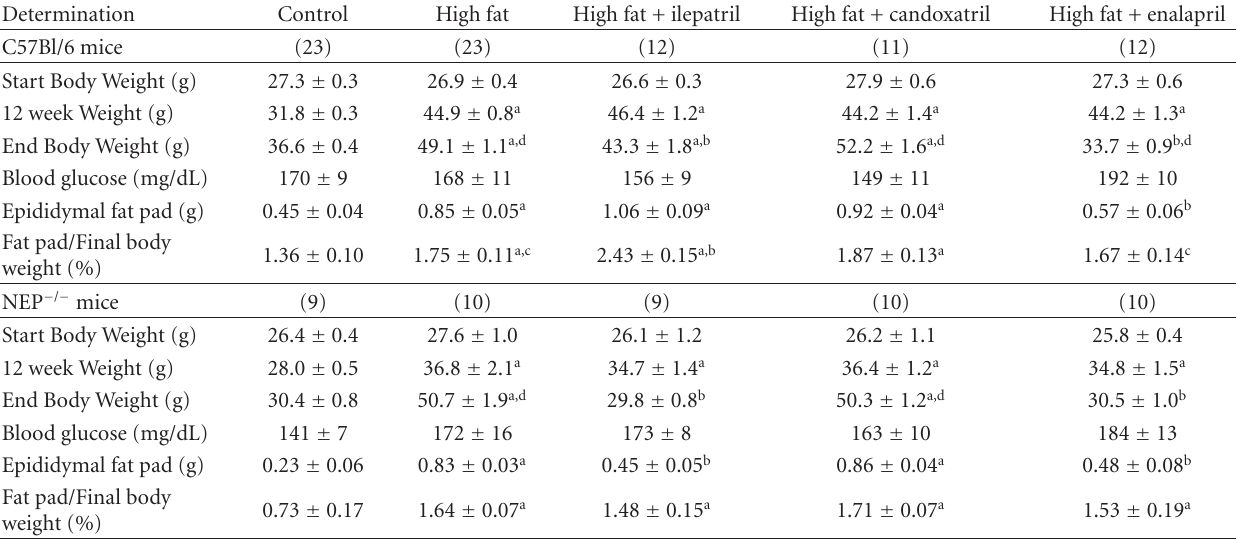
Table 2: Intervention study in C57Bl/6 and NEP − / − mice. E ff ect of high fat diet +/ − ilepatril, candoxatril, or enalapril on change in body weight, blood glucose, and epididymal fat